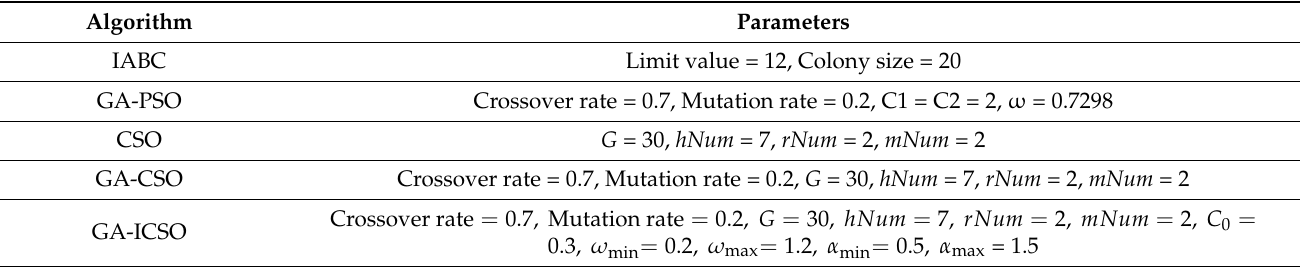
Table 7. GA-PSO, IABC, CSO, GA-CSO and GA-ICSO control